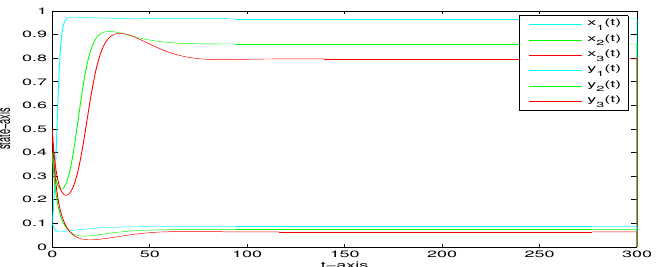
Figure 1. Time-series curves of equilibrium statuses of System (2). The blue line is for = E ∗ ( 0.9669,0.0867 ) ( f = 0 ) , the green line is for E ∗ = E ∗ ( 0.9532,0.0850 ) ( f = 5 ) , and the E ∗ 0 0 red line is for ˆ E ∗ = ˆ E ∗ ( 0.8597,0.0726 ) ( f = 50 ) .